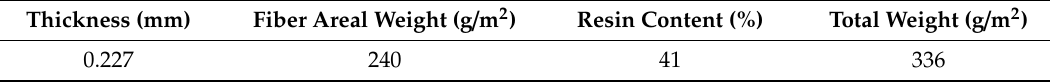
Table 1. Composition of WSN-3k [6]. Table 1. Composition of WSN ‐ 3k [6]. Table 1. Composition of WSN ‐ 3k [6]. Table 1. Composition of WSN ‐ 3k [6]. Table 1. Composition of WSN ‐ 3k [6]. Table 1. Composition of WSN ‐ 3k [6].